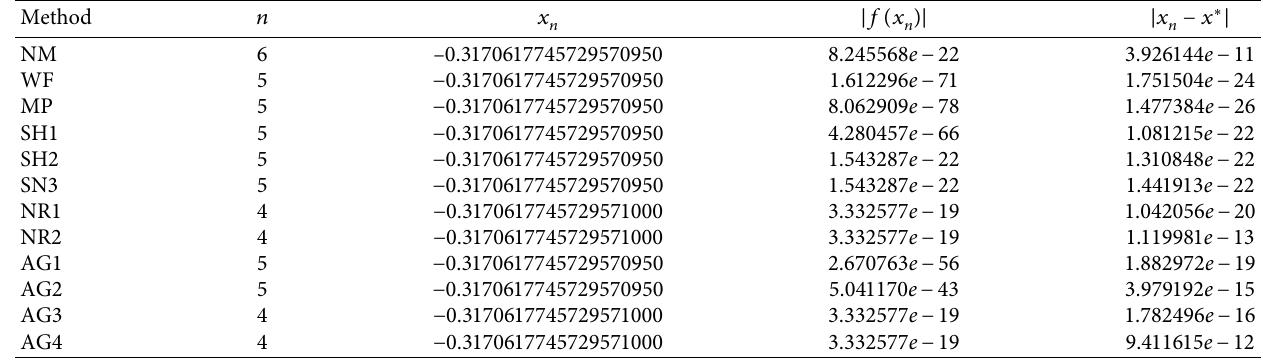
Table 1: Numerical result for motion of a